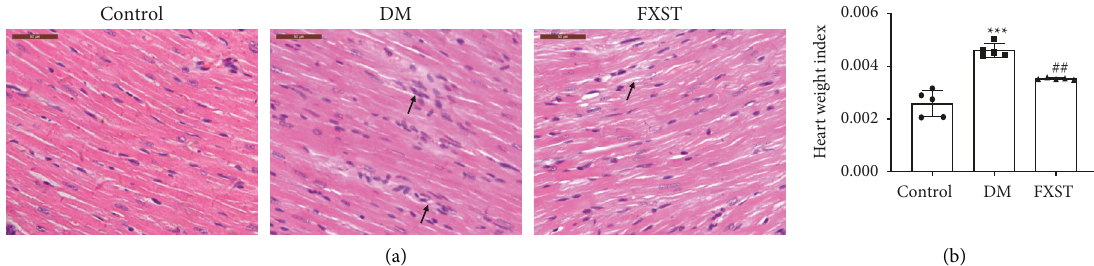
Figure 3: Effects of FXST on myocardial histomorphology and structure in DM rats. (a) Representative images of hematoxylin-eosin staining of myocardial tissues (400 , magnification), arrows represent widened myocardial cell gap and inflammatory cell infiltration. (b) × The heart weight index of each group was calculated. Data are expressed as the mean